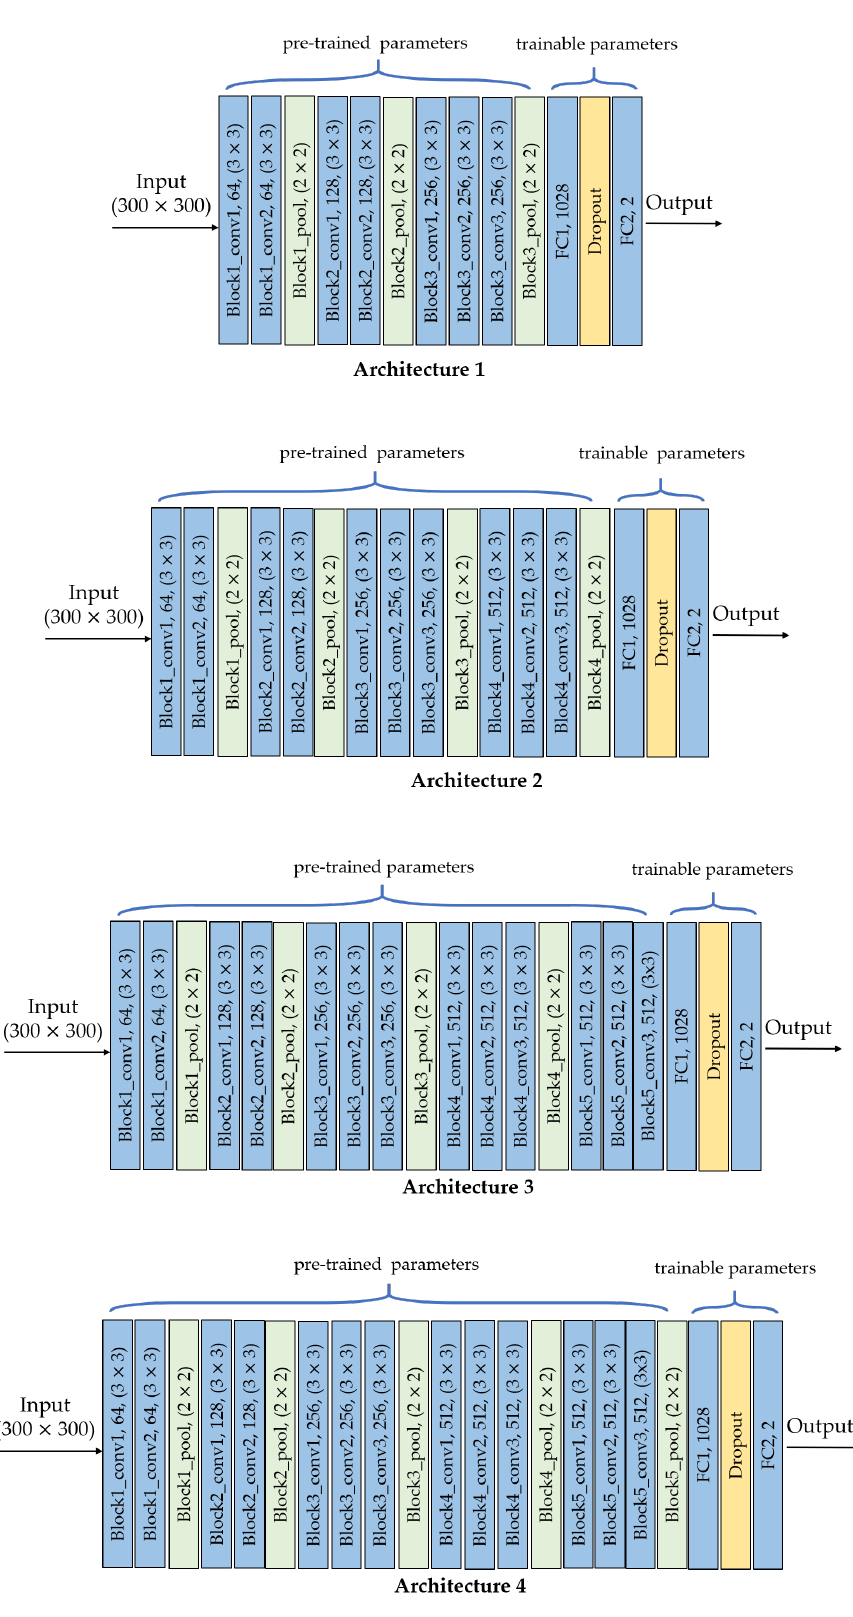
Figure 2. Architectures by TL: conv is convolutional layer, pool is pooling layer, FC is fully- connected